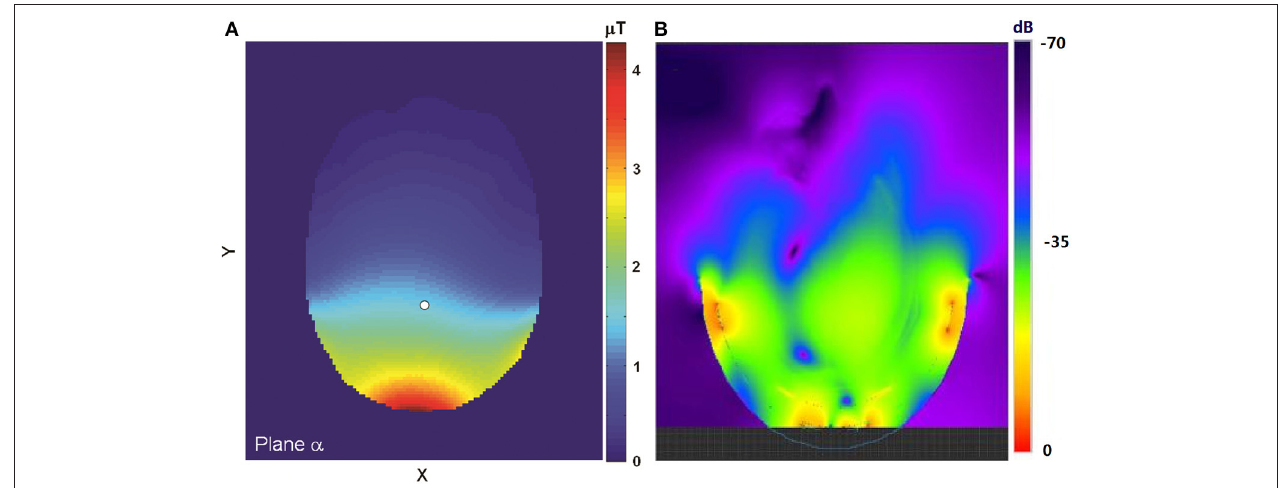
FIGURE 1 | (A) The simulated B 1 + field distribution in an axial plane at 3T. The field strength at the reference point (white dot) is 1.5 µ T at the normalized condition of 1.0 W total RF absorption. Adapted from Li et al. [ 29]. (B) The simulated B 1 + distribution of the proton coil in an axial plane at 7T. The upper boundary of the B 1 + field display was truncated so that the field further away from the coil could be better visualized. Please note that the B 1 field distribution shown here was extended to the RF coil, not masked by the skull. The anatomical structure of the brain overlaid on the B 1 field map can be found in the original figure (Figure 4 in reference [ 33]). Adapted from Li et al. [33].